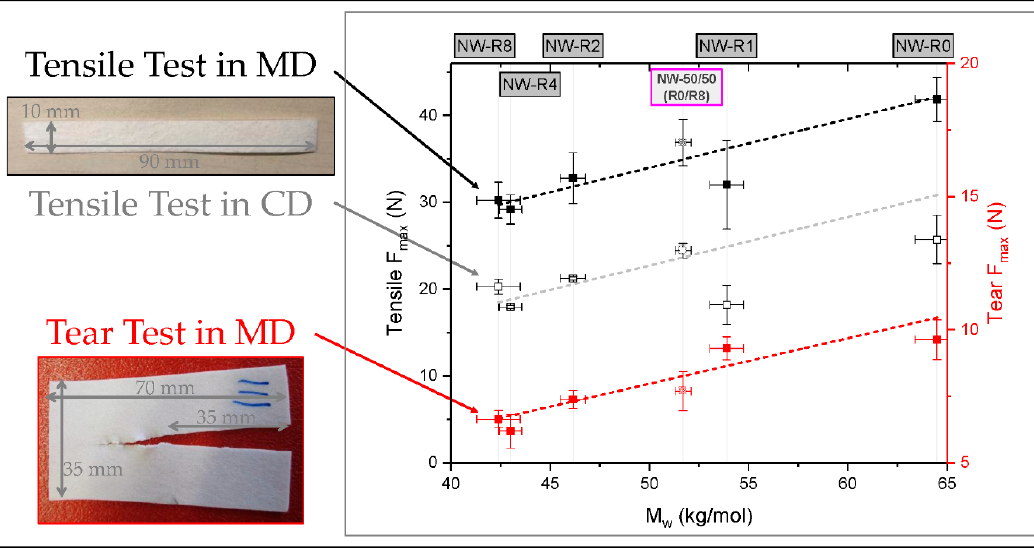
Figure 9. Tensile and tear strength of various nonwoven materials as a function of M w . The top axis indicates the starting material (NW-Rx) for the nonwoven (x = 0, 1, 2, 4, and 8). In addition a mixture of R0 + R8 (50%) is shown (its results are close to R1). The dashed lines are a guide to the eye. Comparing the maximum elongation at break to the respective force (Figure 10), it can be seen that it increases towards the fabric produced from twice recycled material. This can be explained by